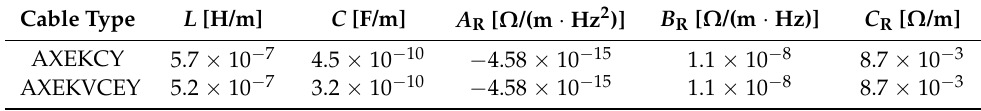
Table 7. Parameters and coefficients for implementation of MV management.